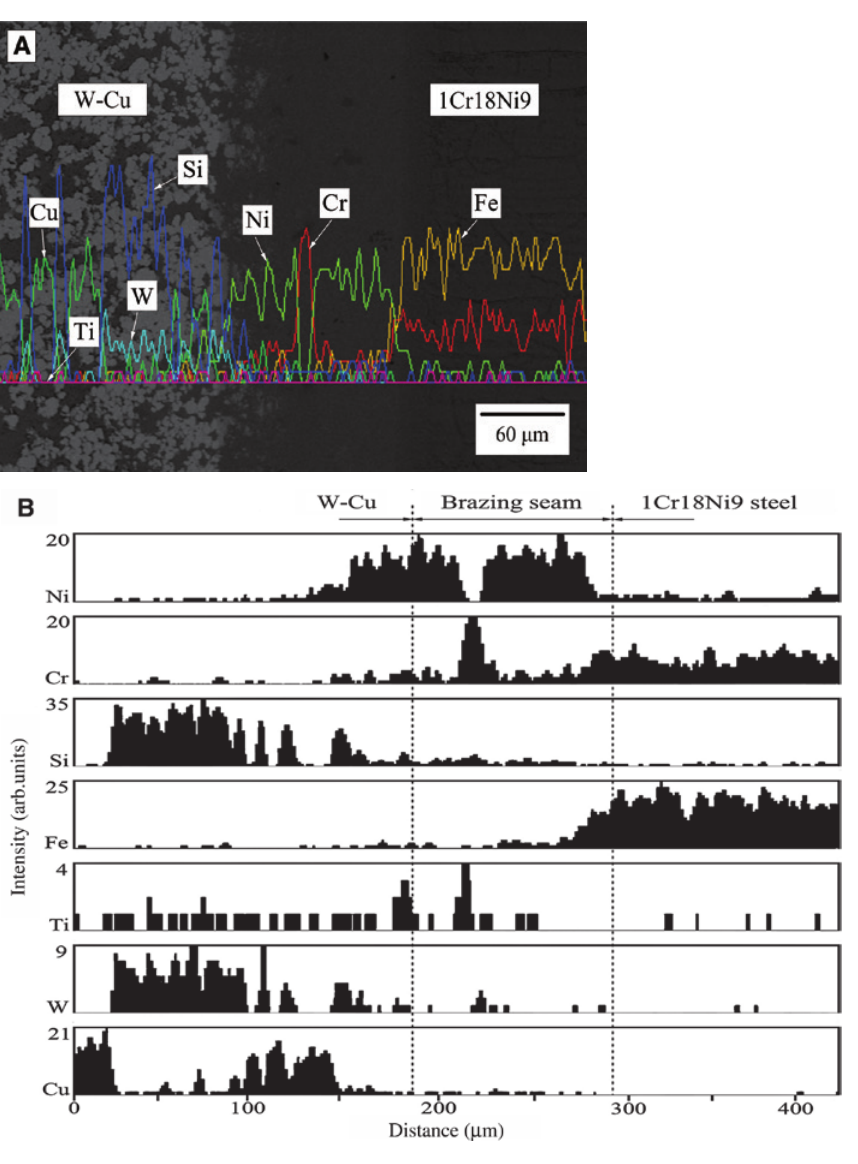
Figure 3: Element distribution near the interface of NiCrSiBFeTi brazed joint: (A) line scan location; (B) element